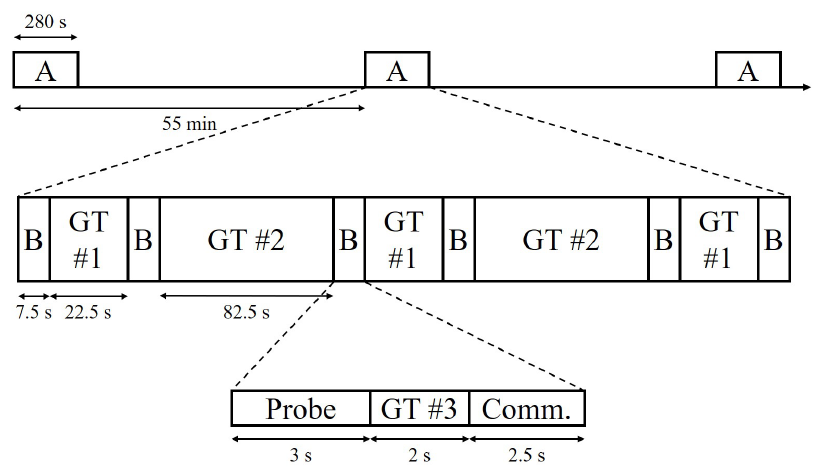
Figure 4. Communication signal transmitted by the source during BLAC18. Each block denoted by the letter { A } (280-s long), consisting of six data packets denoted by the letter { B } (7.5-s long), was repeated every 55 min. Each data packet { B } consists of an LFM signal as a channel probe and a communication sequence. Blocks labeled { GT#1 ∼ 3 } represent guard times that are 22.5-, 82.5-, and 2-s long, in this